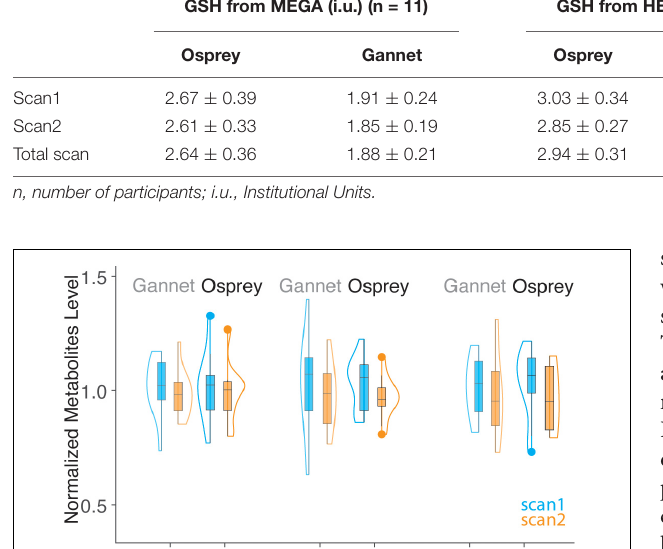
TABLE 1 | Metabolites levels (mean ± SD) from HERMES-80 data and MEGA-120 data processed by Osprey and Gannet. GSH from MEGA (i.u.) (n = 11) GSH from HERMES (i.u.) (n = 12) GABA + from HERMES (i.u.) (n = 12)